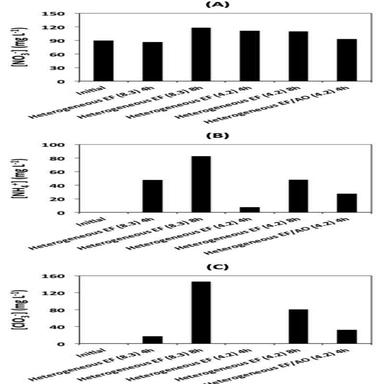
Concentration evolution of main inorganic species of interest during EAOPs as a function of configurations and operating conditions (current density in bracket, mA cm-2 ): (A) ClO3 -, (B) NO3 and (C) NH4 þ. ClO4 was not detected.